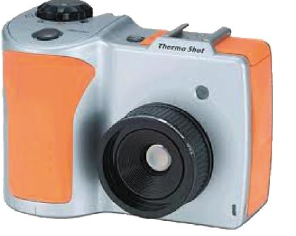
Figure 4. NEC F30 IS (NEC Avio Infrared Technologies Co., Ltd., 2012) thermal camera